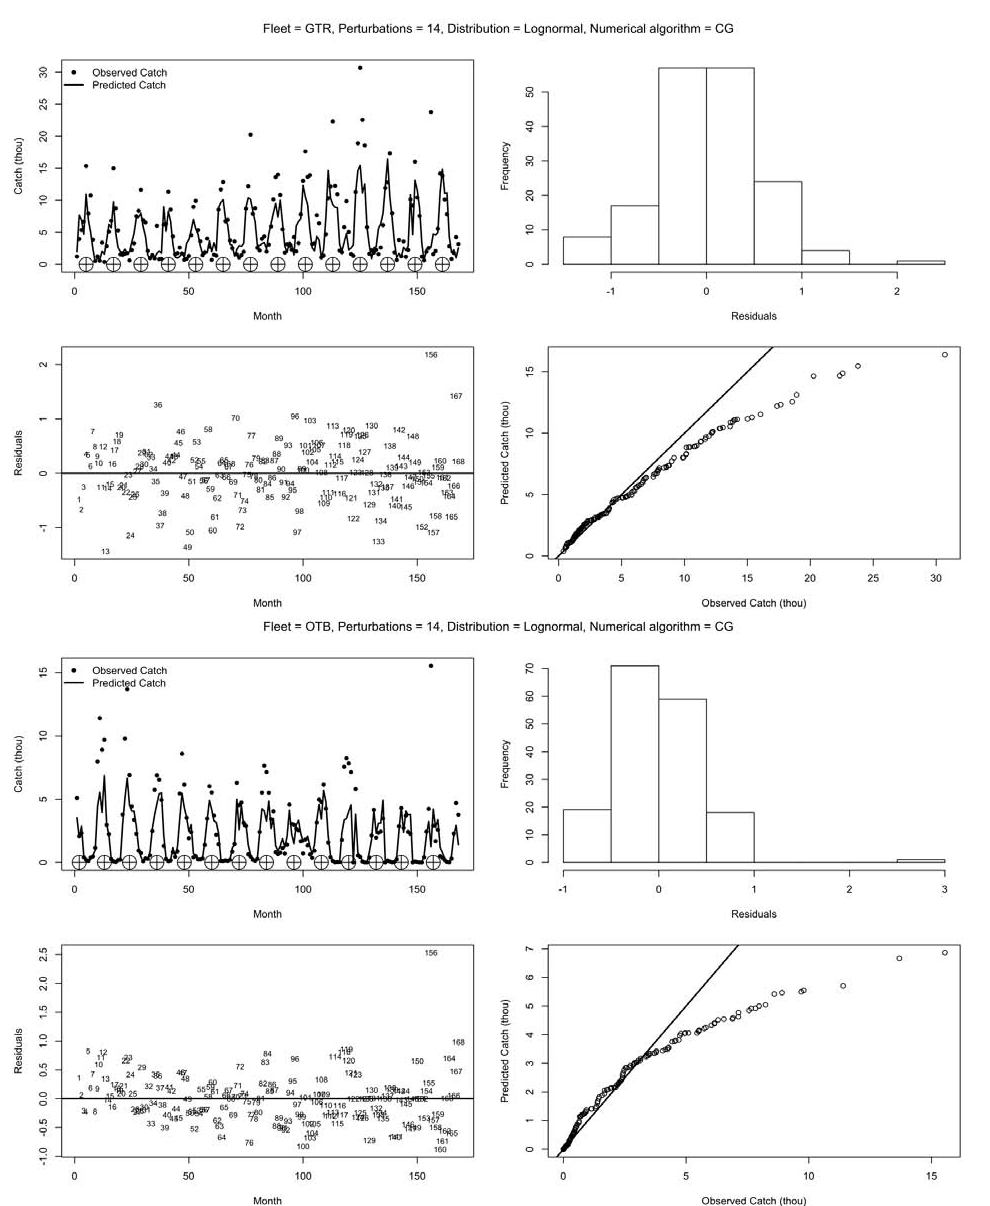
Fig. 7. – (Upper panel: trammel net (GTR); lower panel: bottom trawl (OTB)) Stock assessment prediction results for cuttlefish ( Sepia of- ficinalis ). Top left: predicted (continuous line) and observed catches in number. Target symbol shows the timing of the perturbations. Top right: empirical distribution of the residuals. Bottom left: scatter plot of the residuals. Bottom right: quantile-quantile plot of the generalized depletion